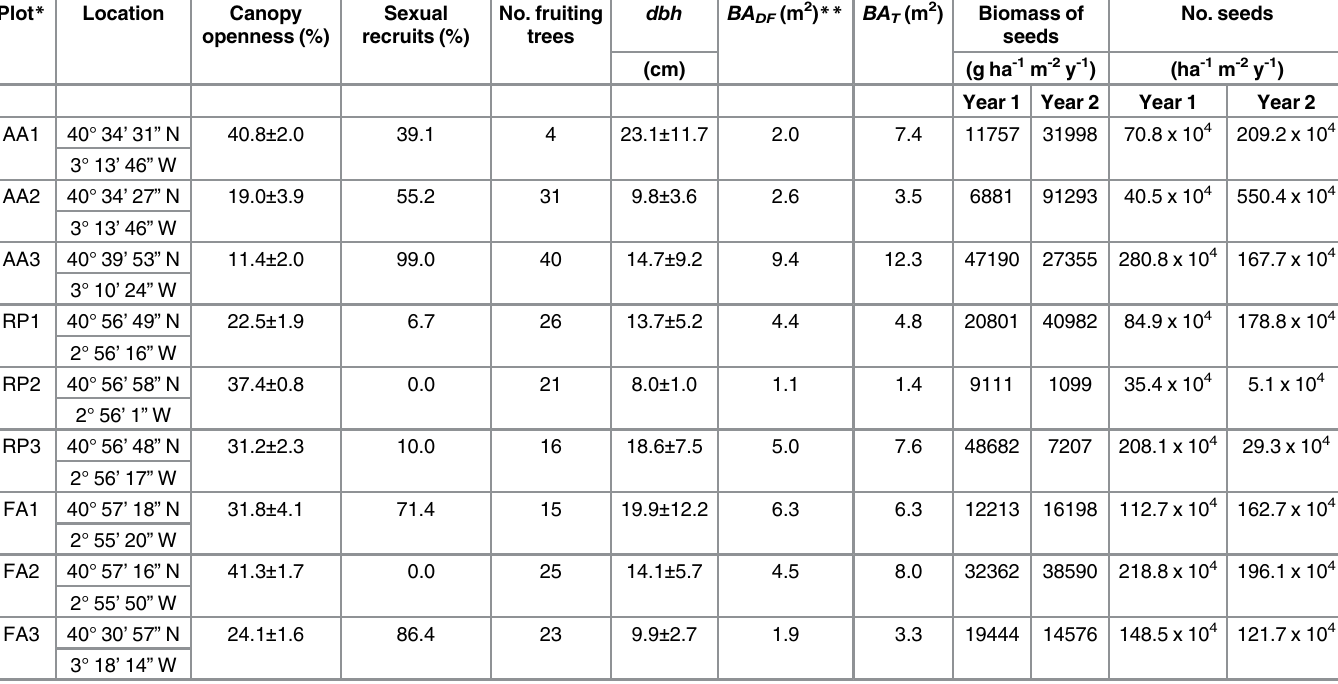
* Plot names: AA: plot with dominance of the invasive species A . altissima ; RP: plot with dominance of the invasive species R . pseudoacacia ; FA: plot with dominance of the native species F . angustifolia . ** Note that unlike BA D , BA DF represents only the basal area of fruiting trees from the dominant species in the